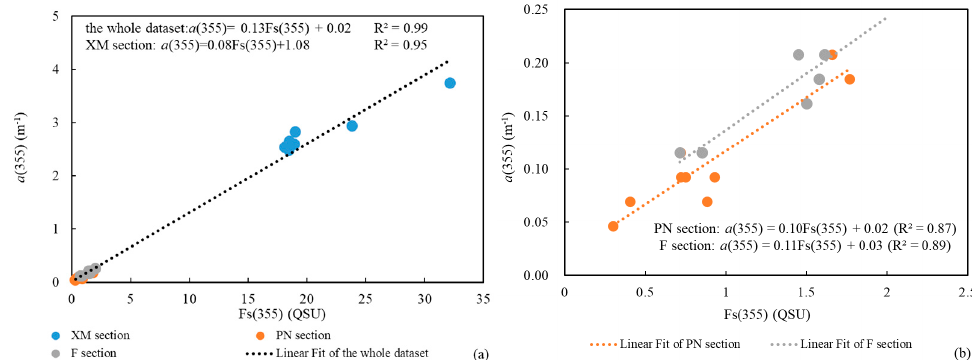
Figure 7. Relationship between Fs(355) and a ( 355 ) . ( a ) Entire dataset for all three sections; ( b ): dataset for sections PN and F. Strong positive correlations between Fs(355) and a ( 355 ) were found in sections PN and F.